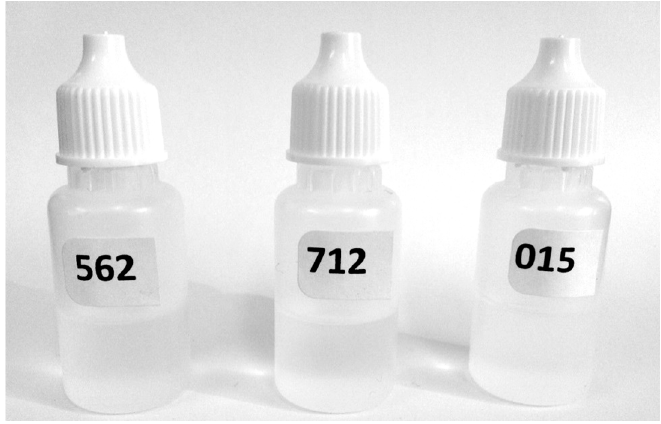
Figure 1. Image of sniffing bottles for oleic acid olfactory measurement using the ascending 3-AFC procedure.